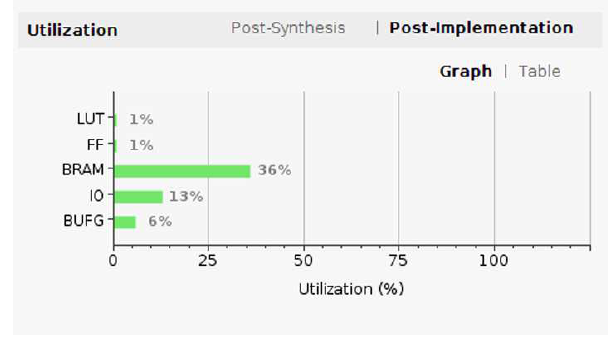
Figure 7. MATLAB result of Canny Operator.